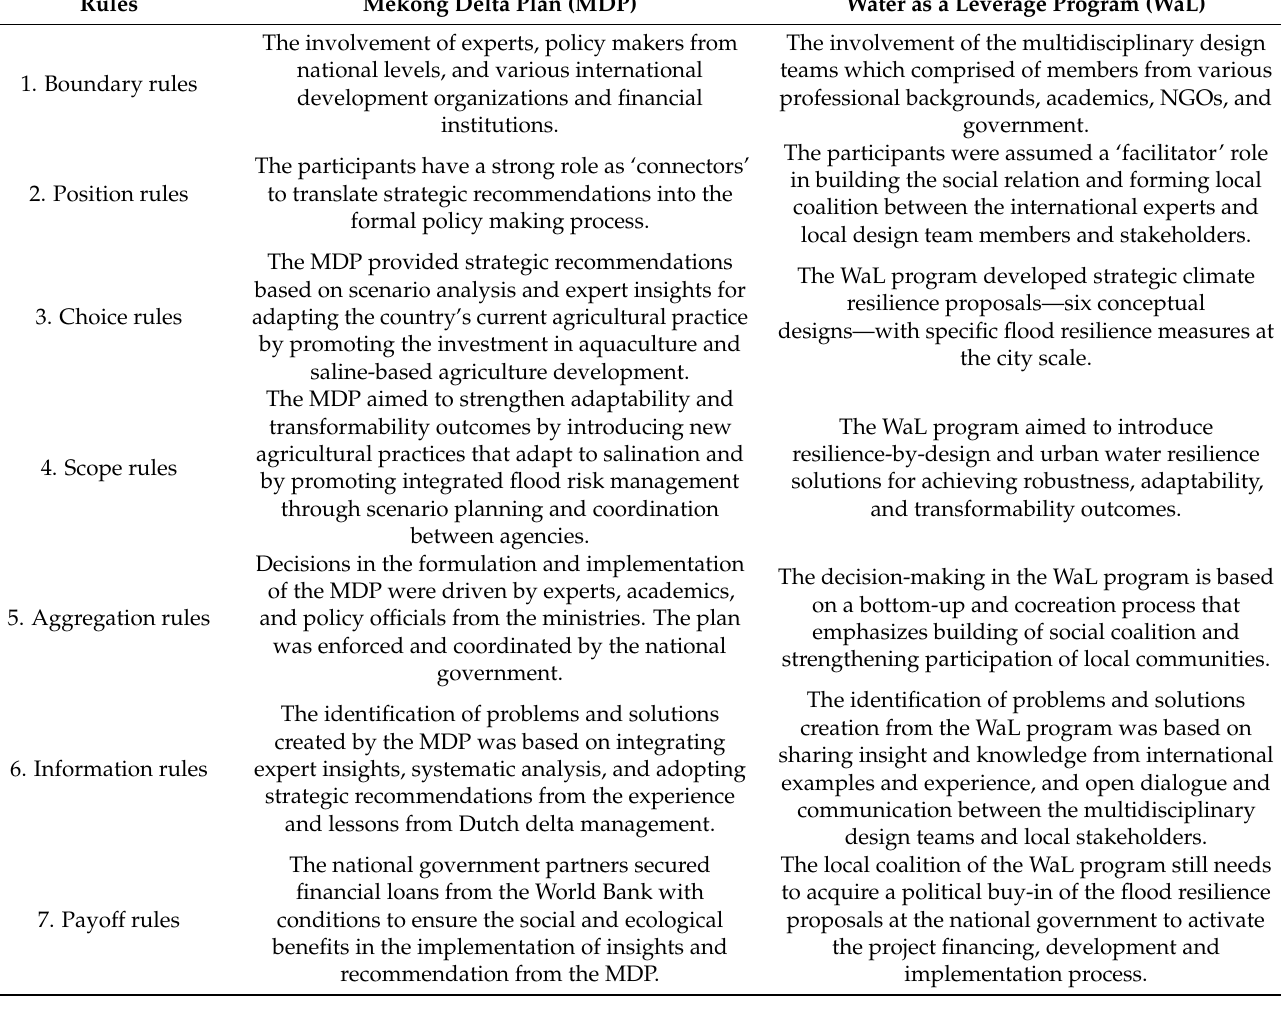
Table 3. The essential institutional conditions based on the rules-in-use derived from the MDP and the WaL program.